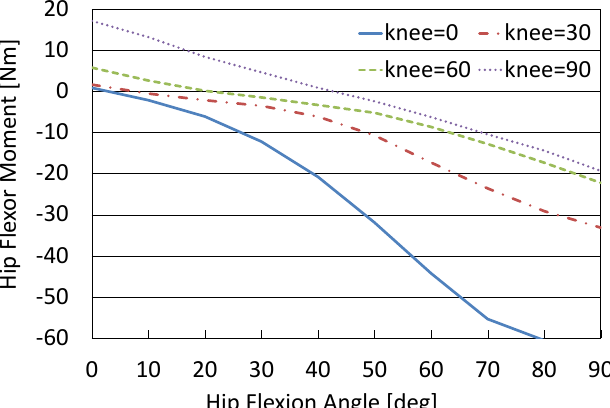
Figure 6 Calculated passive resisting moments at the hip with various knee angles are plotted against the hip flexion